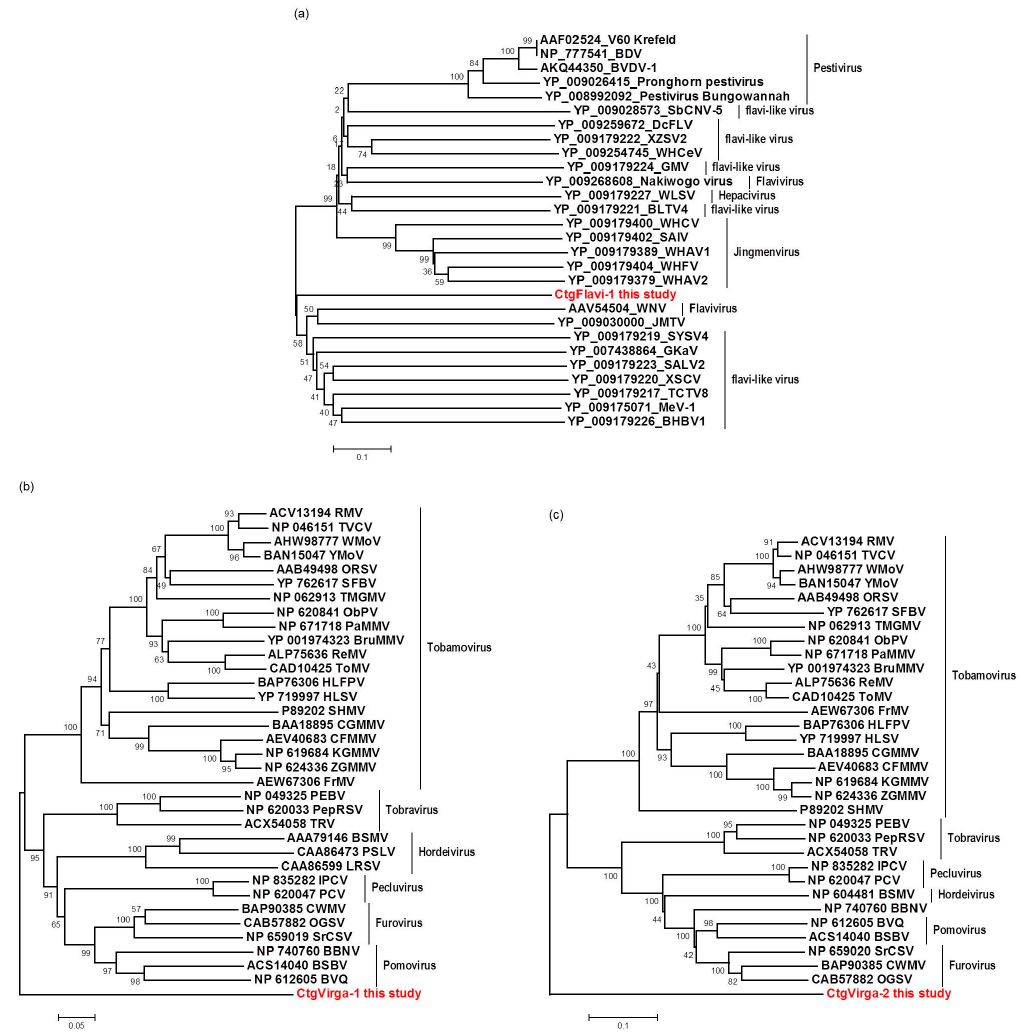
Figure 7. Phylogenetic relationships among helicase ( a , b ) and RdRP ( c ) amino acid sequences from representative isolates of the families Flaviviridae ( a ) and Virgaviridae ( b , c ), including the respective viral sequences identified in this study. Bootstrap values are shown as percentages and the viral sequences obtained in this study are highlighted in red.